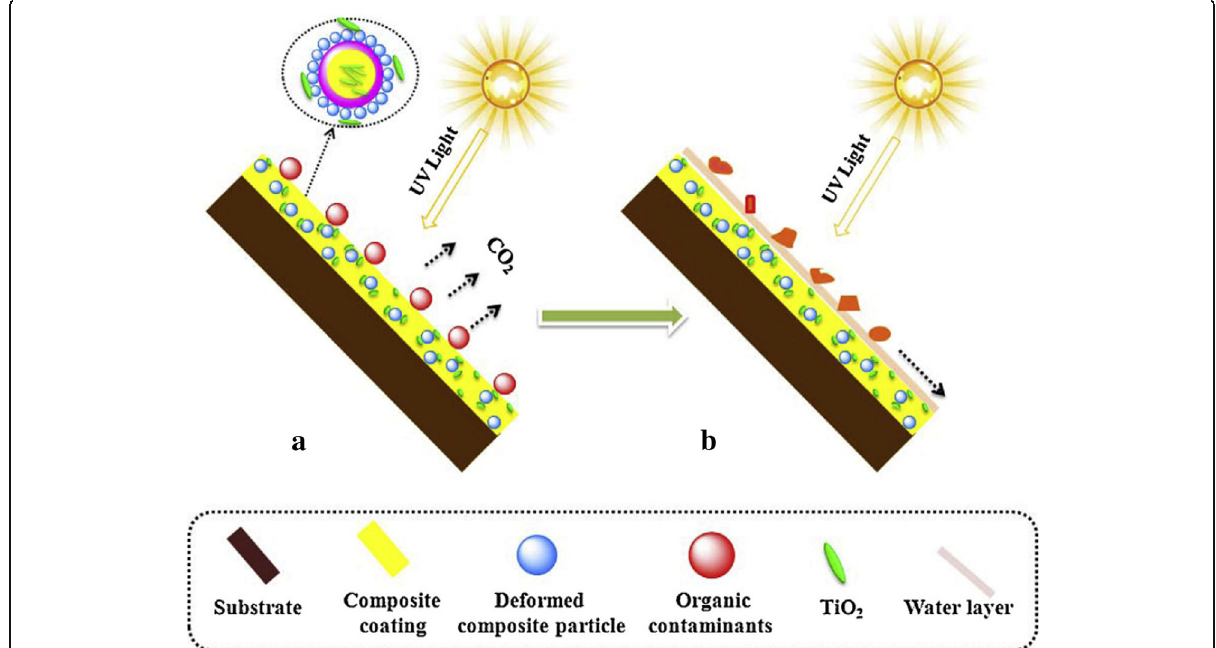
Fig. 6 Schematic illustration of the self-cleaning behavior of casein-based TiO 2 composite coatings in the initial ( a ) and intermediate ( b ) stage [29]. Copyright 2016, Elsevier